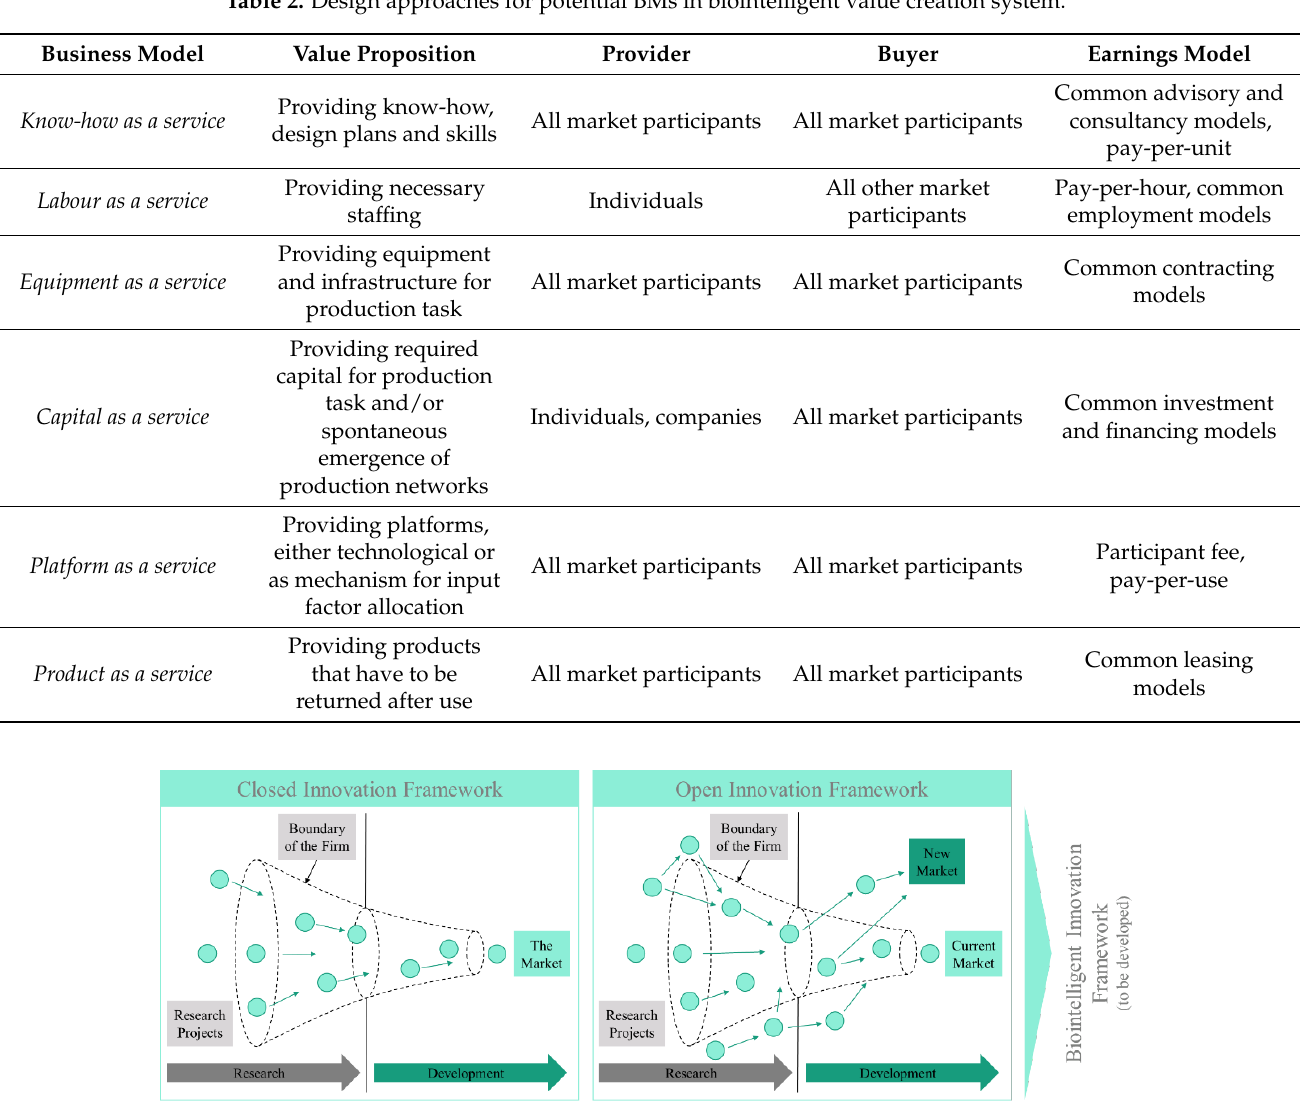
Figure 6. Difference between closed and open innovation frameworks according to Simic [62].